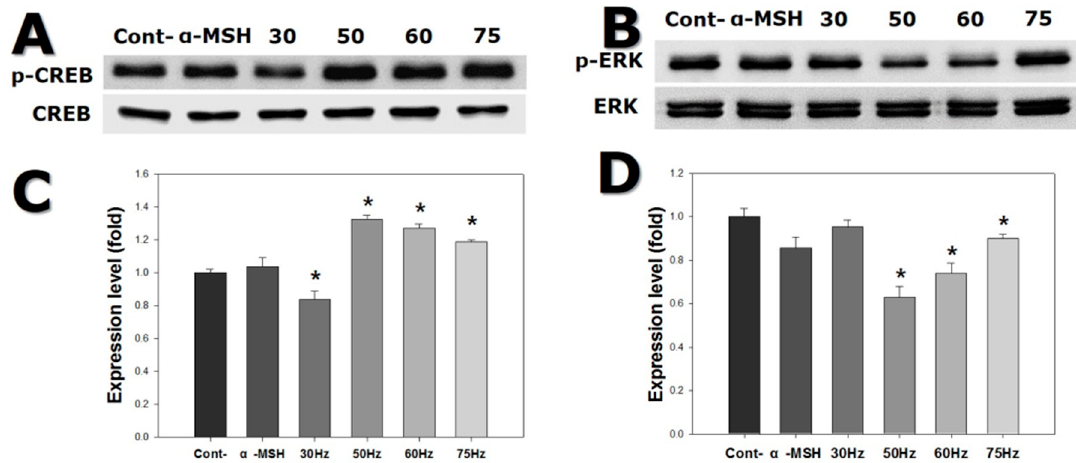
Figure 6. Western blot of cyclic adenosine monophosphate response element-binding protein (CREB) and extracellular signal-regulated kinase (ERK) expression in melanocytes after exposure to extremely low frequency electromagnetic fields for 72 h. ( A ) CREB and phosphorylated-CREB (p-CREB) banding; ( B ) p-CREB expression; ( C ) ERK and phosphorylated ERK (p-ERK) expression; ( D ) p-ERK expression. Each bar represents the mean ± standard error of independent experiments performed in triplicate ( n = 5). * p < 0.05, compared to the control (Cont).